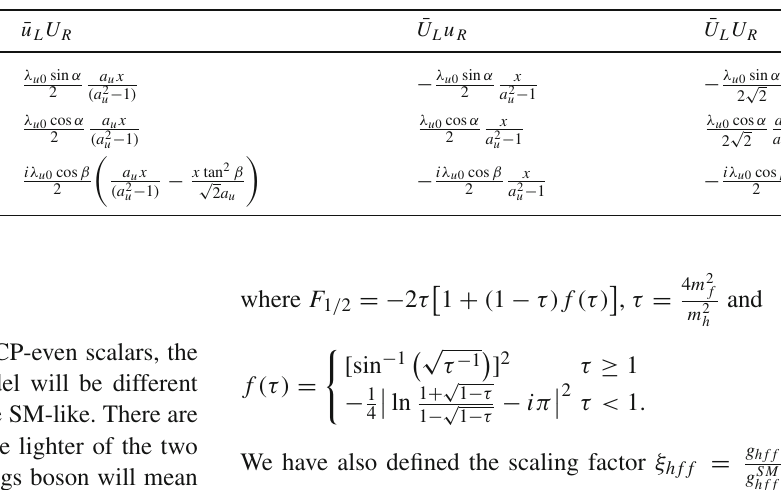
Fig. 4 The yellow shaded region corresponds to the allowed benchmark points after recasting the unitarity condition for our model considering different value of sin α Table 4 The couplings of the neutral scalars to the fermions in the model – these have been evaluated in the limit ε R → 0 and to O ( x 2 ) . The couplings with the down-type fermions can be obtained via the substitutions λ u 0 → λ d 0 and a u → a